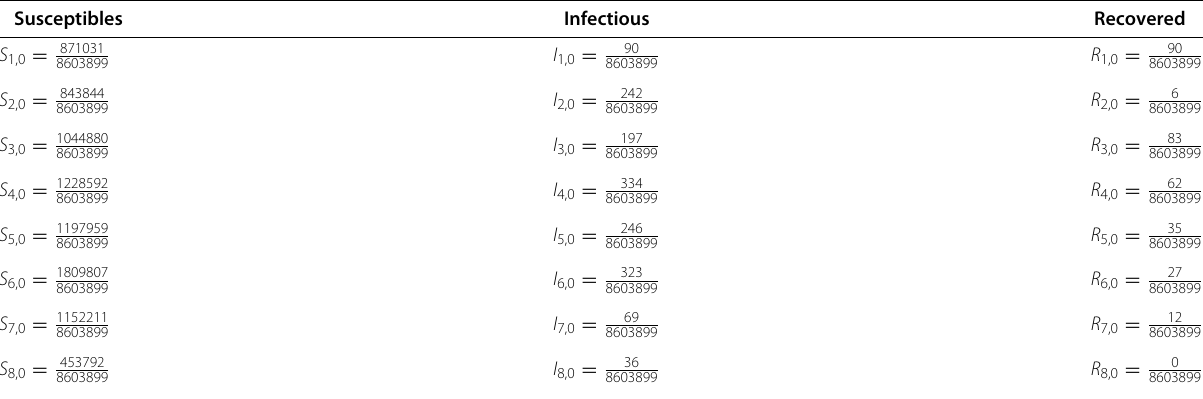
Table 9 Initial values—SIR model